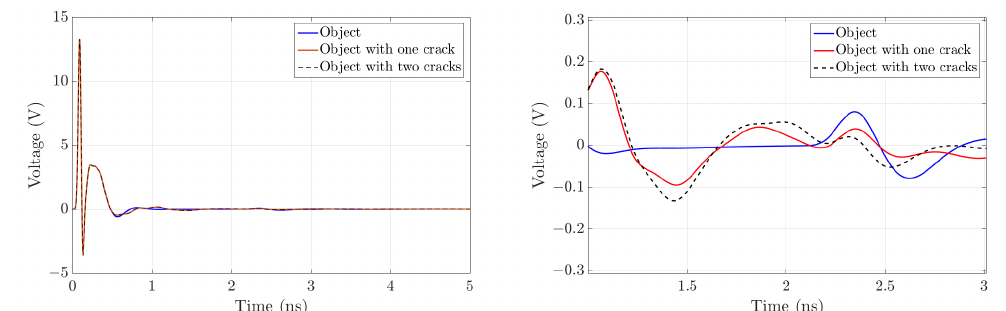
Figure 3. Comparison of reflected voltages in three different objects.